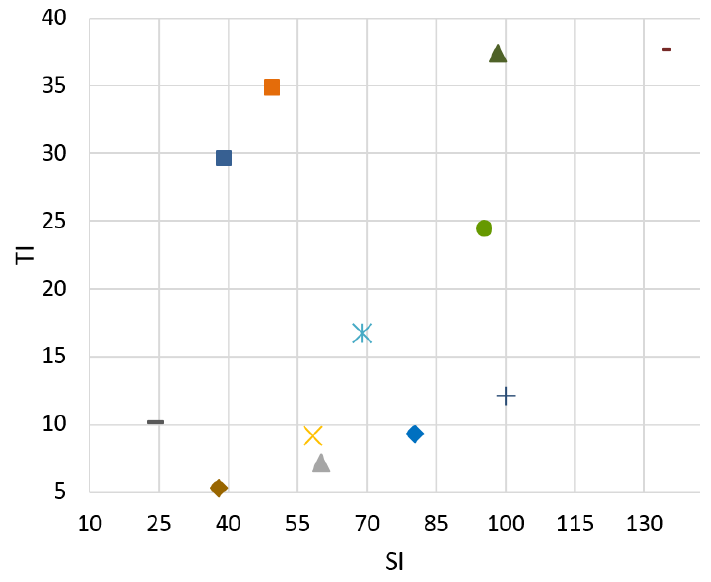
Figure 6. Full HD, H.265, bitrate 3